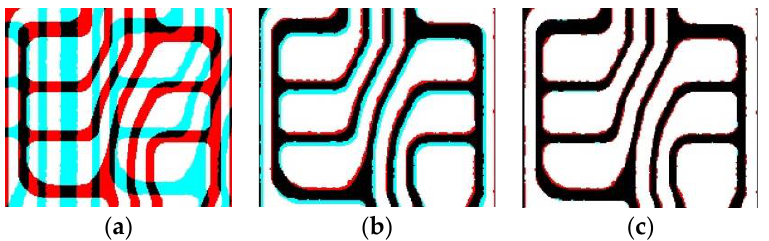
Figure 2. The proposed registration algorithm. ( a ) Before registration. ( b ) Coarse registration result. ( c ) Fine registration result.